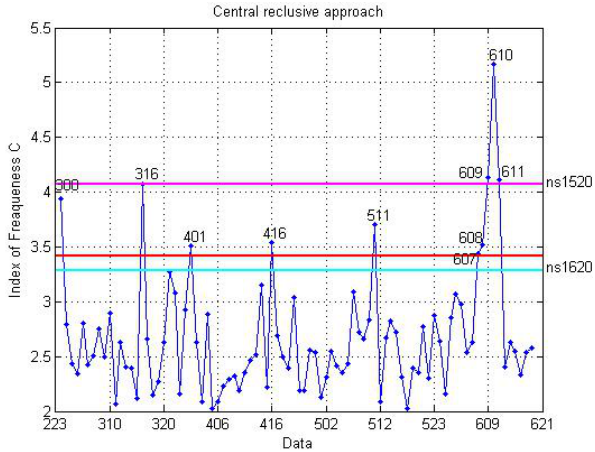
Figure 12 Same as Figure 11 with calculated IFC: index of freaqueness based on Central reclusive approach corresponding to the data shown in Figure 7. Fig. 12. Same as Fig. 11 with calculated IFC: index of freaque- ness based on Central reclusive approach corresponding to the data shown in Fig.